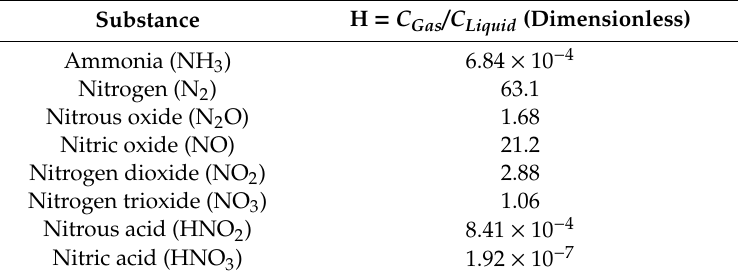
Table 1. Henry’s law solubility constants at 298.15 K